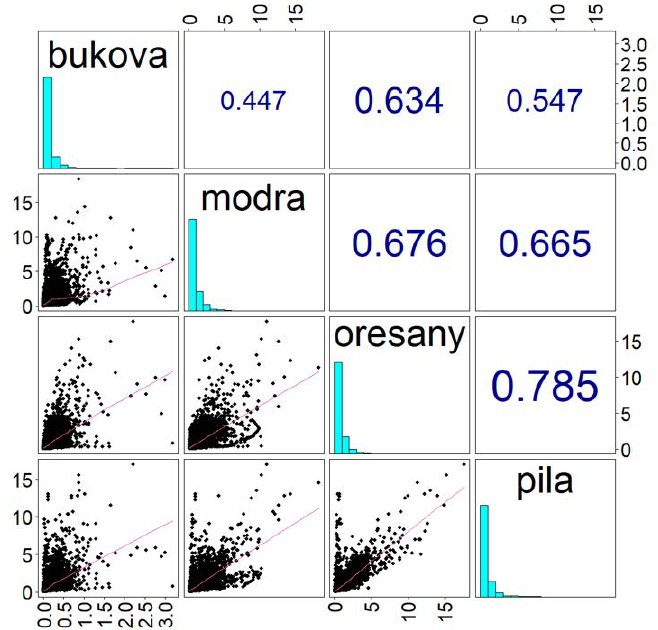
Figure 13. Correlation matrix of the specific flows of the catchments under